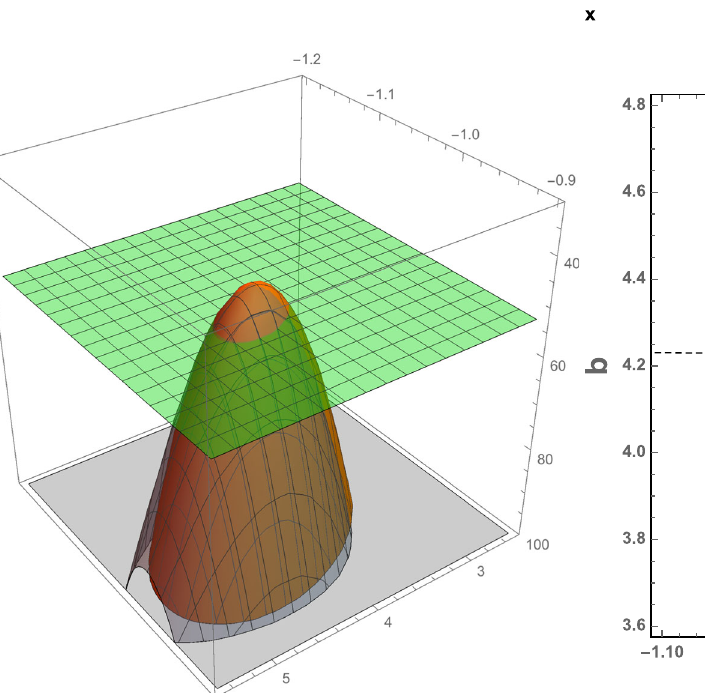
with the ellipse (that occurs in the quadratic approximation) are shown as the black dots in the right panel. The numbers label the eigenvector of H corresponding to that direction